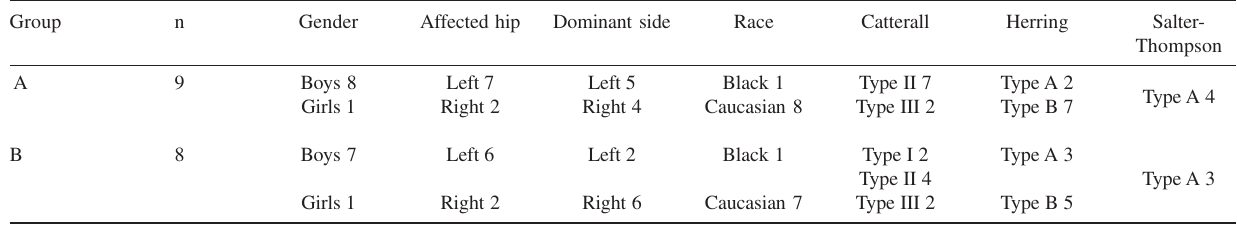
Table 1 - Distribution of the patients in groups A and B, according to sample size, gender, affected hip, dominant side, race, and radiographic classification (Catterall, Herring, and Salter-Thompson) Group n